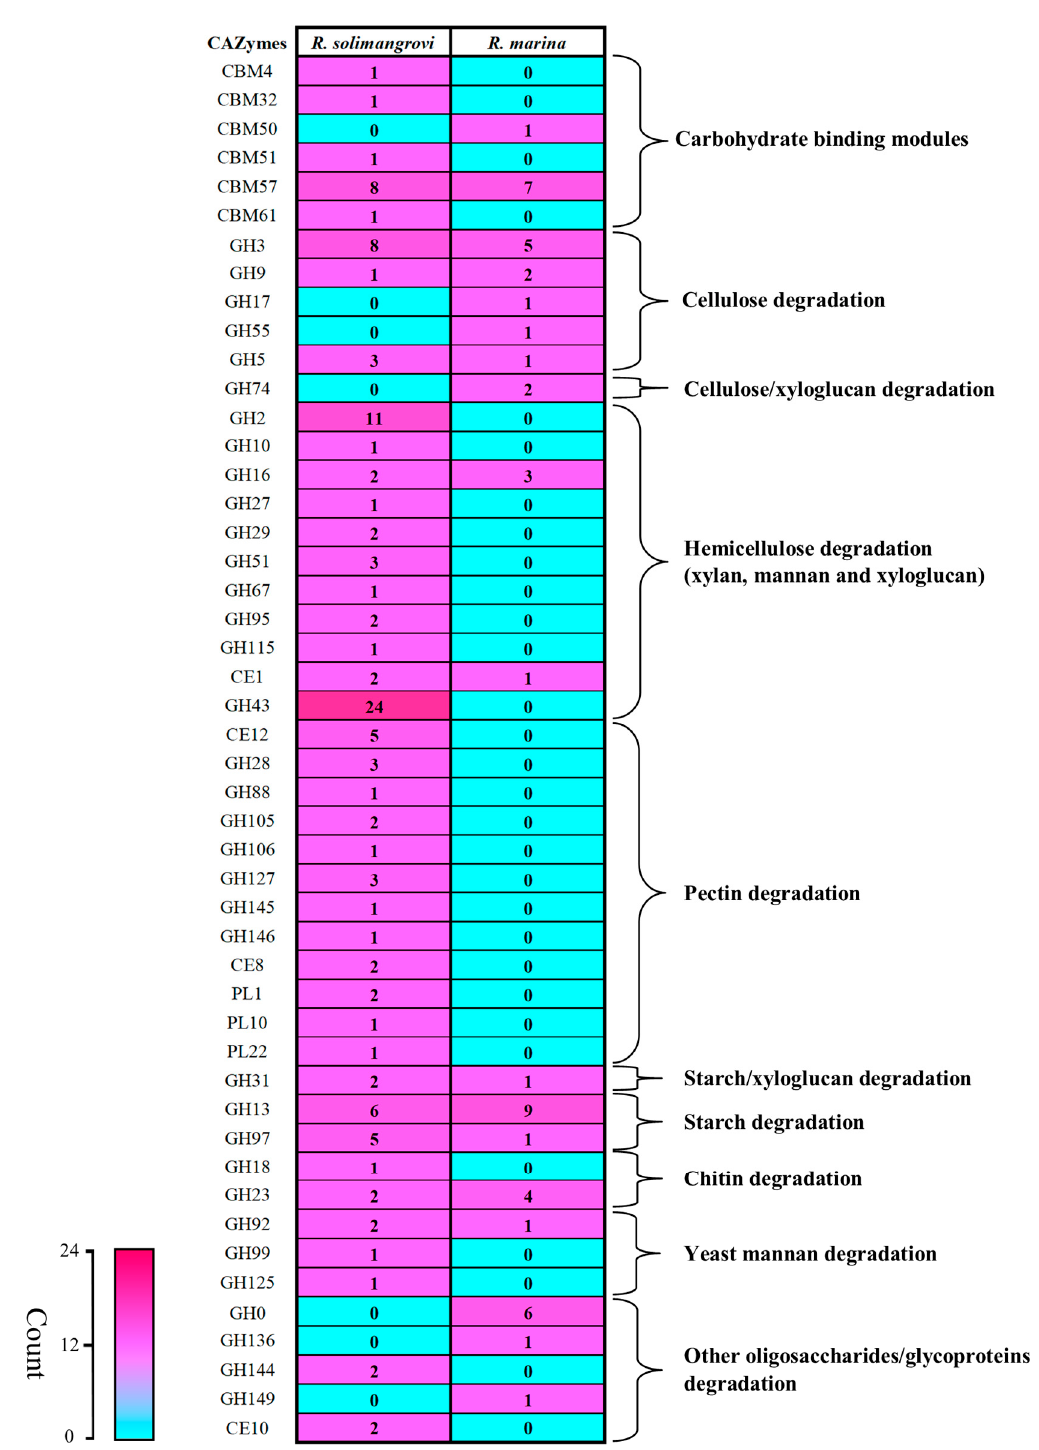
Figure 2. Comparative genomic analysis for polysaccharide degrading GHs, CEs, PLs and CBMs between Robertkochia solimangrovi and Robertkochia marina.